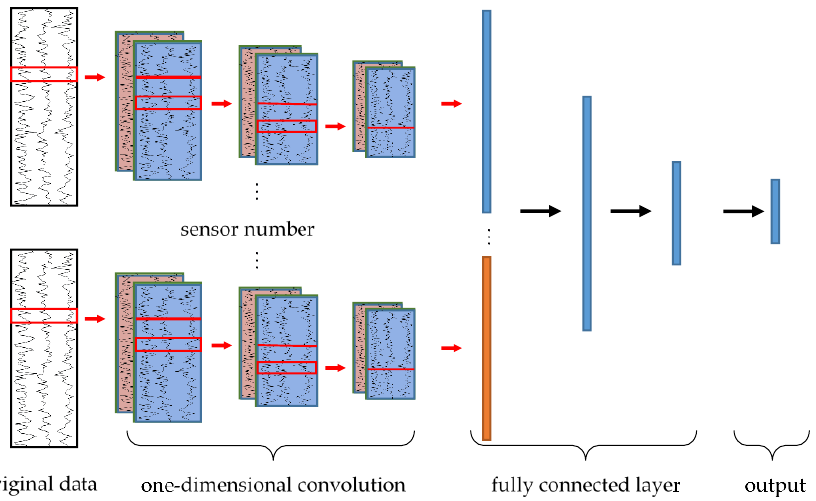
Figure 5. The convolutional neural network (CNN) network of human activity recognition. Each convolutional network is for a set of data in a sensor. Then the outputs of the convolutional network are spliced together to be the input of the fully connected layer.